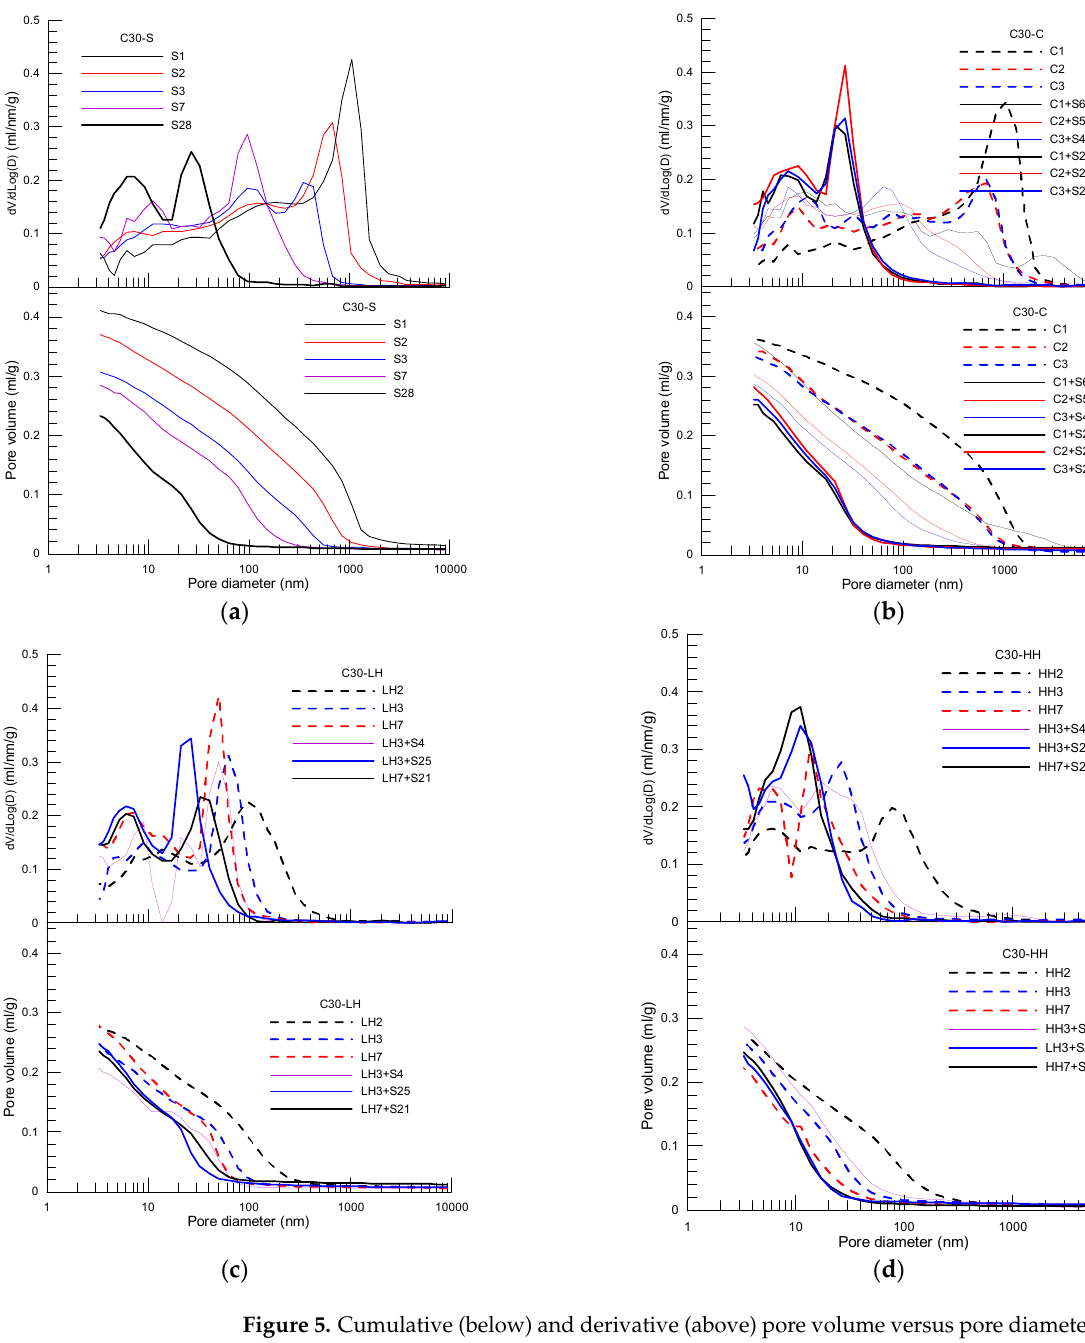
and 0.2605 mL/g, respectively, of the paste subject to 1, 2 and 3 days insulation curing, respectively. The corresponding pore volume at 28 days of standard curing is 0.2330 mL/g. This indicates that the rising curing temperature (below 35 ◦ C, see Figure 2a) leads to an increase in porosity of the cement paste. Third, according to the classification shown in Figure 4, at 28 days, the capillary pore (V2) and gel pore (V3–V2) volume of the pastes subject to 1, 2 and 3 days insulation in the initial period after casting are (0.142, 0.111); (0.141, 0.141) and (0.149, 0.112) mL/g, respectively. The pore size of d3 is 13.73, 17.1 and 13.72 nm, respectively, which is comparable to that of standard curing.